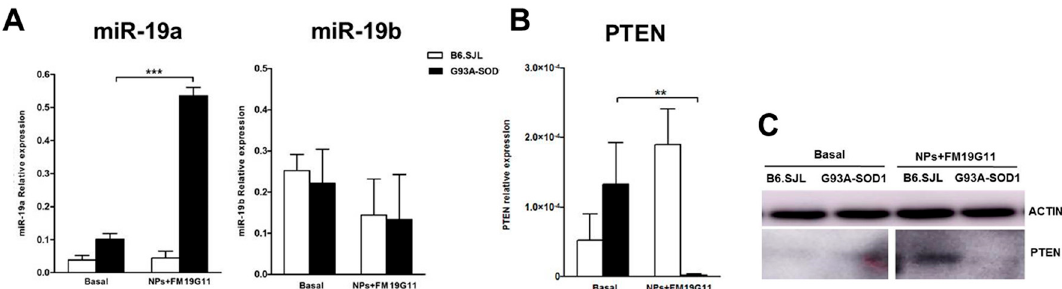
Figure 5. Analysis of cell cycle-related miRNAs and PTEN expression. ( A ) qRT PCR expression analysis of miR-19a and miR-19b in 12-week B6.SJL (white bars) and G93A-SOD1 (black bars) epSPCs after 48 h of FM19G11-loaded NP treatment compared to basal conditions. Expression levels reported as mean ± SD of 2 − ∆ CT values normalized against the miRNA control U6 ( n = 5 different primary cell cultures from five animals per group). ( B ) qRT PCR expression analysis of phosphatase and tensin homolog ( PTEN ) target gene in 12-week B6.SJL (white bars) and G93A-SOD1 (black bars) epSPCs after 48 h of FM19G11-loaded NP treatment compared to basal conditions. Expression levels reported as mean ± SD of 2 − ∆ CT values normalized against the endogenous control 18S ( n = 5 different primary cell cultures from five animals per group). ( C ) Representative Western blot analysis of PTEN and β -actin ( n = 2 different primary cell cultures from two animals per group). ** p < 0.01, *** p < 0.001 by ANOVA followed by Bonferroni post-hoc test.